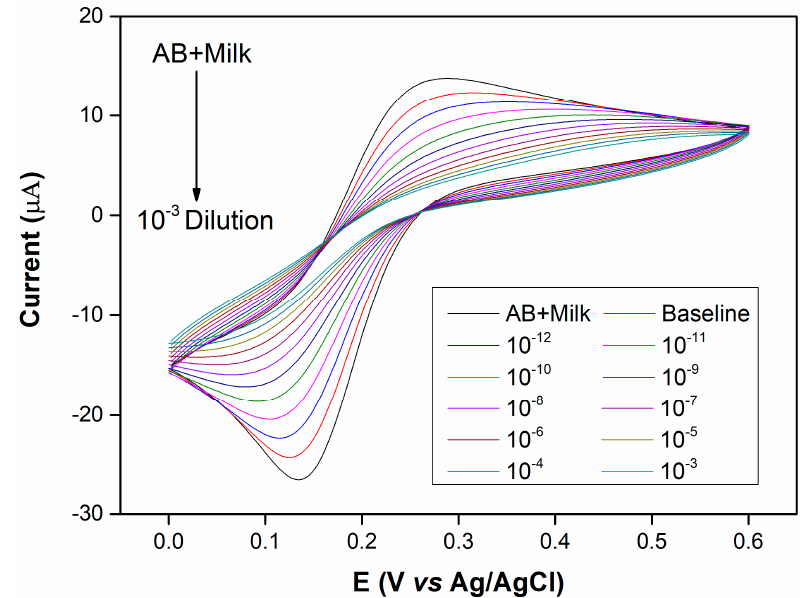
Figure 3. CVs (scan rate: 50 mV s − 1 ) carried out for the rabbit anti-human IgG covered surface, baseline solution (plain PBS) and increasing plasma concentrations from 10 − 12 to 10 − 3 10-fold dilutions of albumin depleted human plasma for the Alzheimer’s disease (AD) (1) case. Tested in 10 mM PBS containing 5 mM [Fe (CN) 6 ] 4 − /3 − and 150 mM NaCl. Electrode surface area: 0.02 cm 2 . Control (1) results were presented in Figure S1.